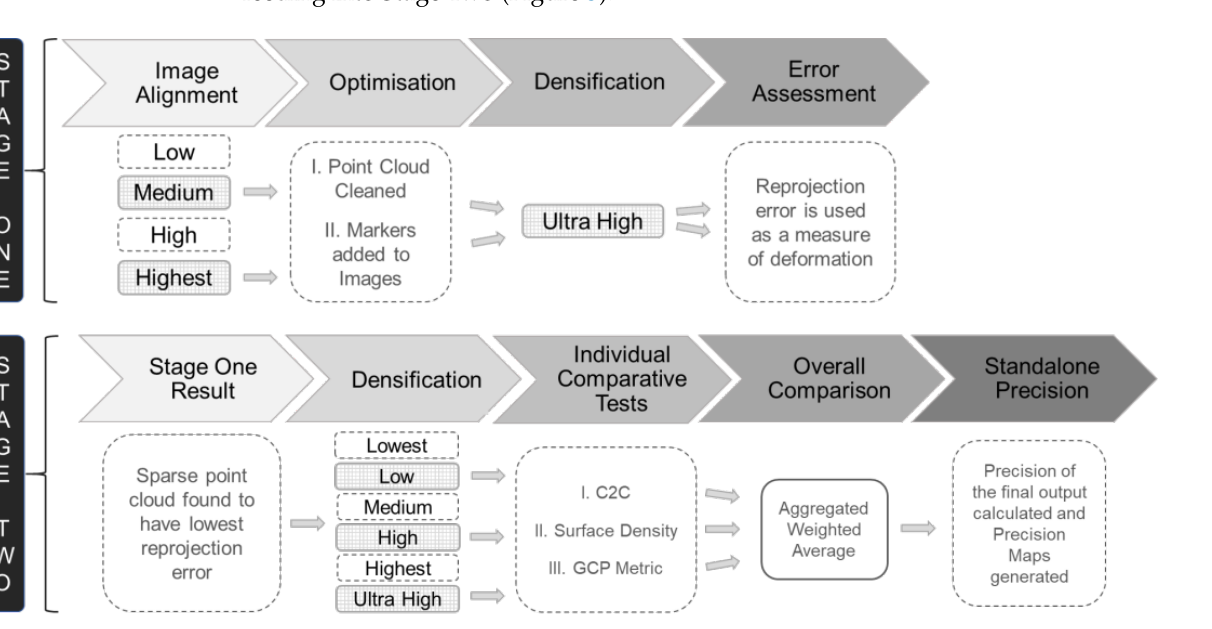
Figure 3. Workflow depicting the process of point cloud generation and assessment. Cross-hatching reflects the parameters used in processing.